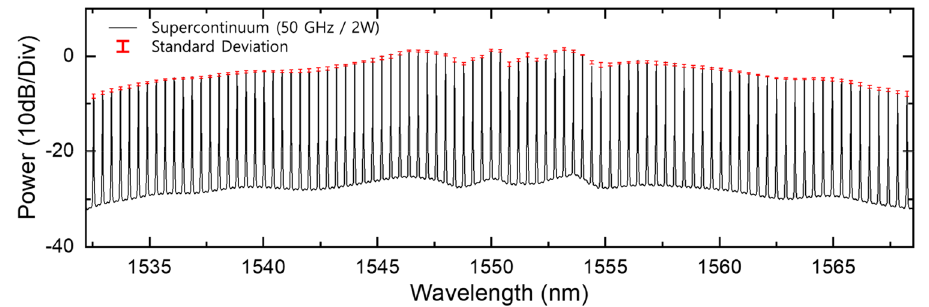
Figure 7. Experimentally measured supercontinuum spectrum and long-term stability measurement over 3 h. Black: supercontinuum spectra, red: standard deviation of supercontinuum.